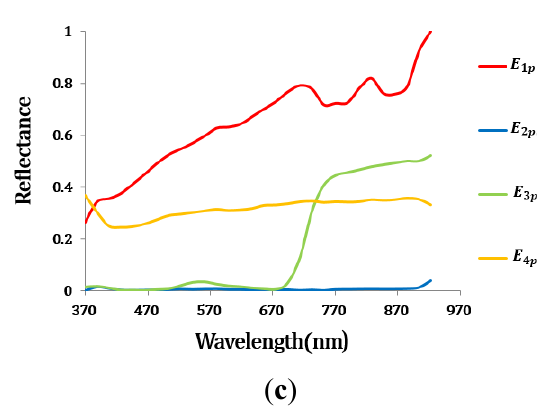
Figure 11. The spectra of the endmember sets for the CASI data. ( a ) After the first step; ( b ) After the second step; ( c ) After the final steps.